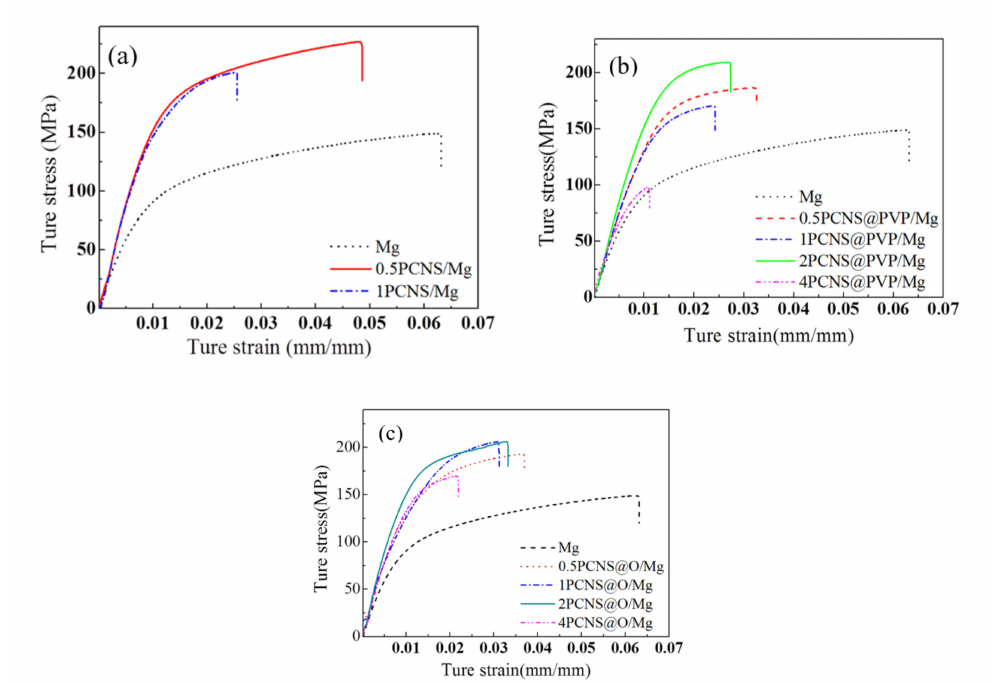
Figure 10. xPCNS@O / Mg composites.